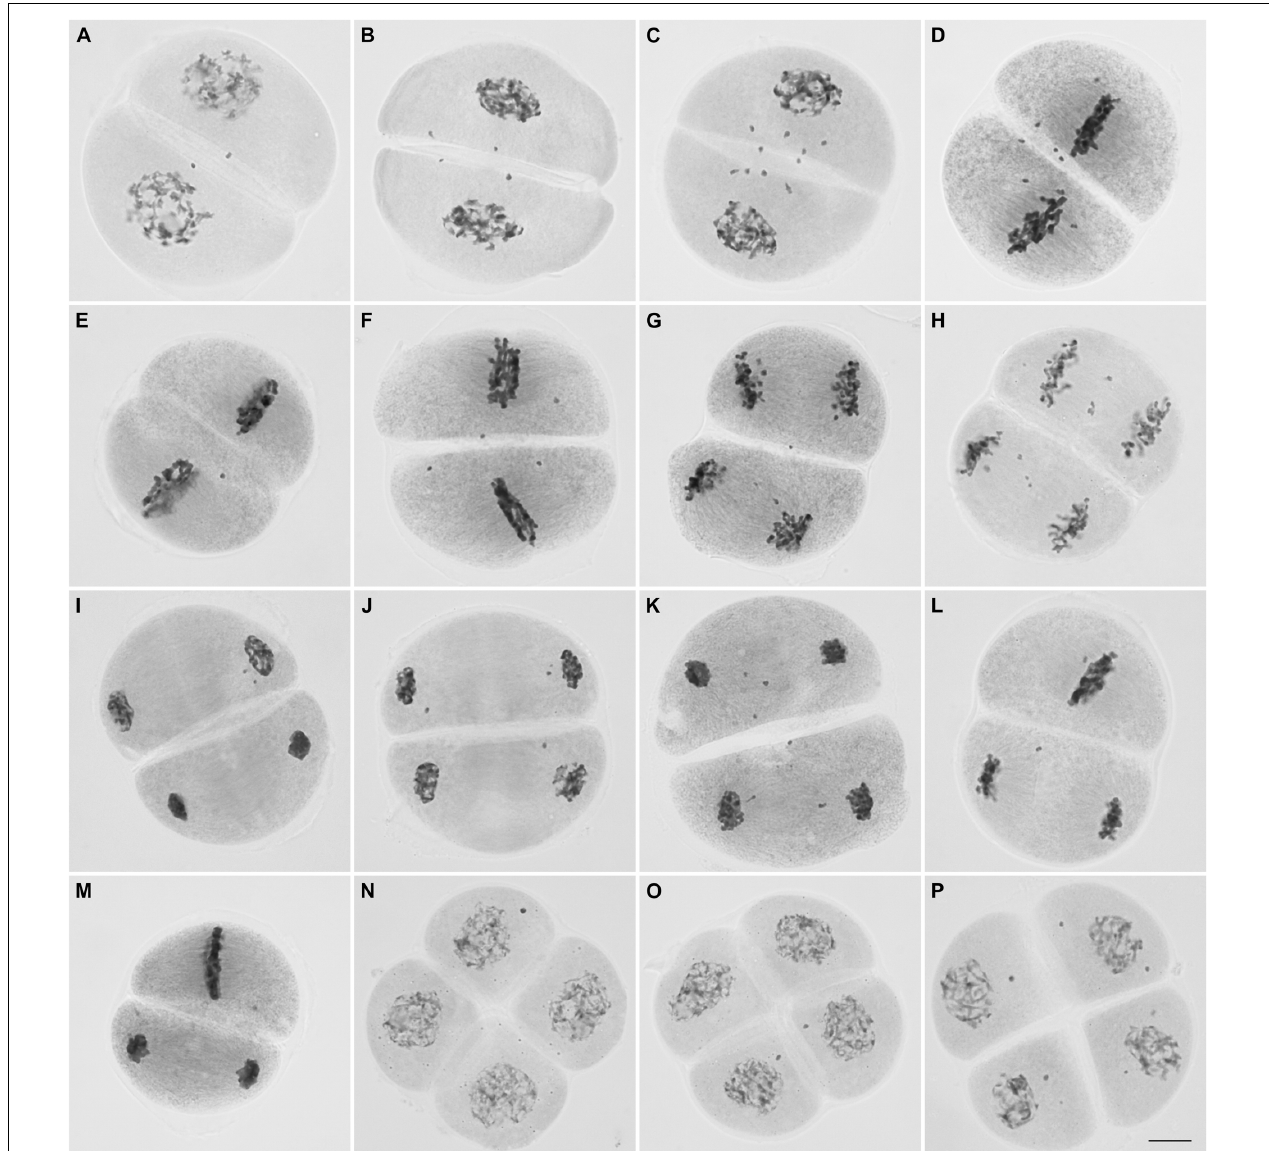
FIGURE 4 | Microsporocytes of IACSP93-3046 during meiosis II. Prophase II cells showing chromosomes (2–10) not incorporated in the nuclei (A–C) . Chromosomes not lined up at the metaphase plate (D–F) . Lagging chromosomes at anaphase II (G, H) . Chromosomes not incorporated into the telophase II